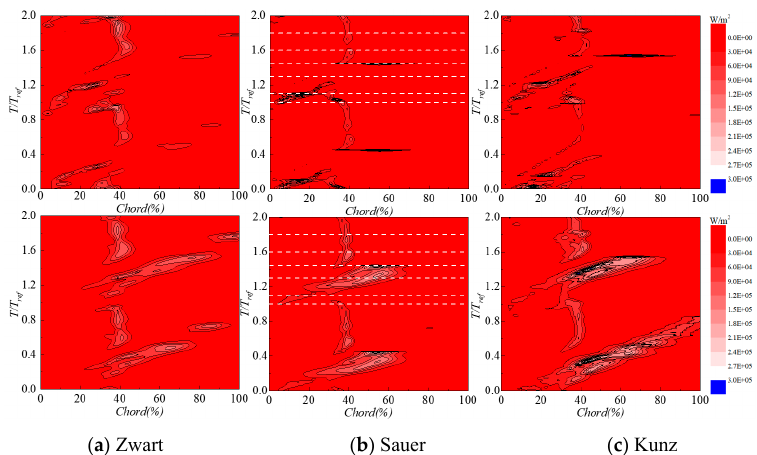
Figure 5. Comparison of calculated power load per unit area, P load , on the hydrofoil surface based on instantaneous pressure, p(t) (top) and on average pressure, p (bottom).